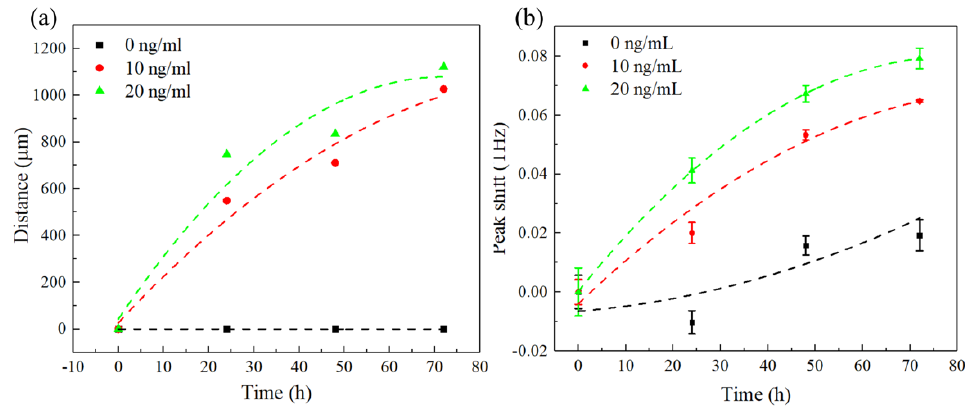
Figure 8. ( a ) The dependence of growth distance on time under different concentrations of TGF − β (0, 10, 20 ng/mL); ( b ) the dependence of peak shift on time under different concentrations of TGF − β (0, 10, 20 ng/mL).